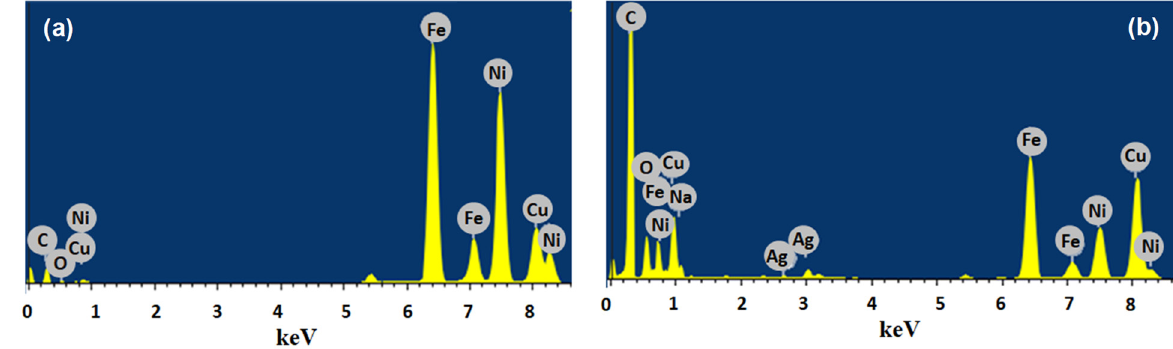
Figure 2. The EDX spectra of ( a ) nZVI (Fe 0 ) nanoparticles and ( b ) Fe/Cu/Ag (5:1:0.2). Table 1. Atomic composition extracted from the XPS of nZVI (Fe 0 ), Fe/Ag (5:0.1), Fe/Cu (5:1) and Fe/Cu/Ag (5:1:0.2) nanoparticles. Sample Element